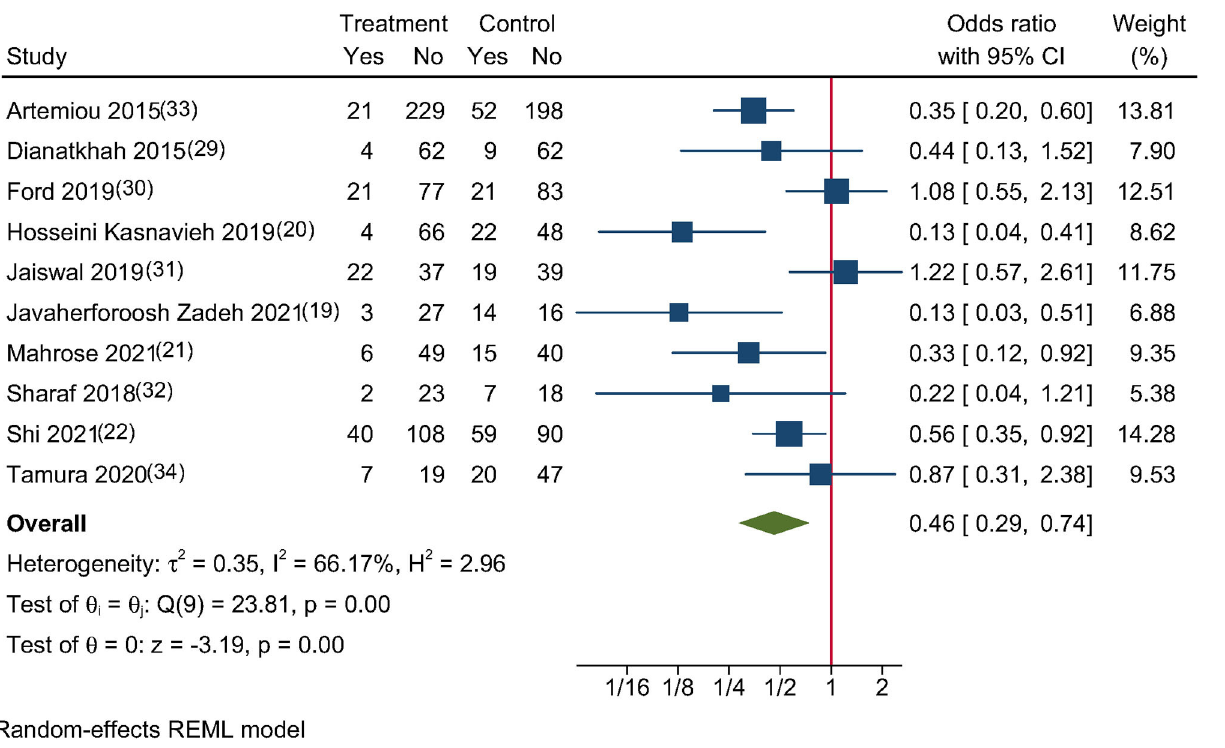
FIGURE 2 | Forest plot for POD incidence in adults who underwent cardiac